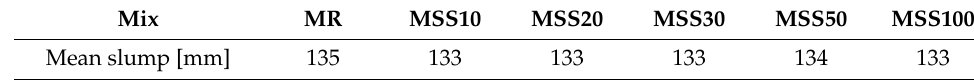
Table 3. Mean values in slump test in accordance with EN 1015-3.